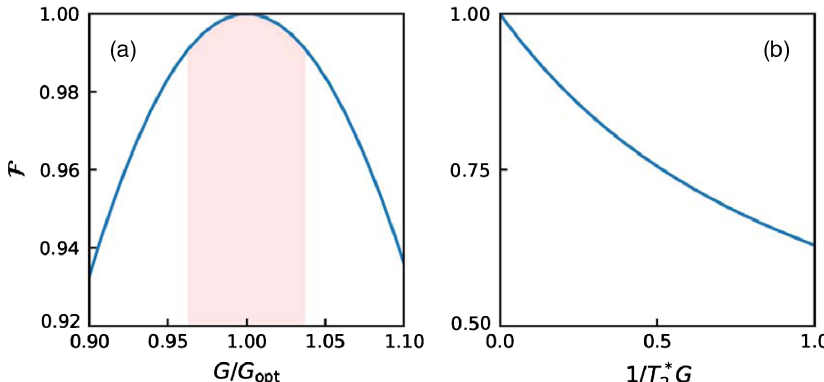
4 Unhandled opt ¼